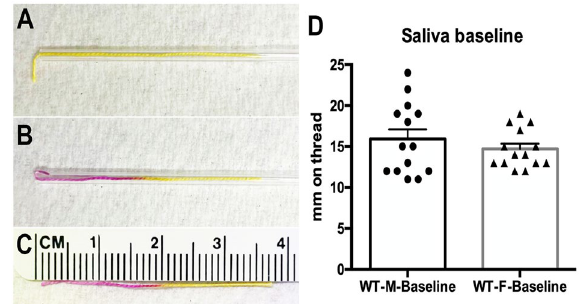
Figure 1. Capillary based method for measuring basal salivation in mice. ( A ) Phenol red-coated thread is inserted into a fire-polished glass capillary with 3 mm extending outside the opening. This is then placed under the tongue of an isoflurane anesthetized mouse for 10 s. ( B ) Saliva travels up the thread, discoloring it. ( C ) The distance traveled in mm is taken as a measure of basal saliva. ( D ) Sample baseline data for WT males and females shows that basal levels are similar (n = 14 per